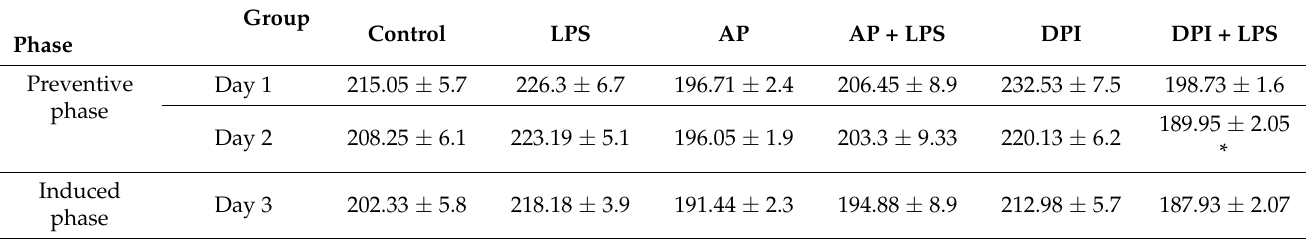
Table 1. Regular assessment of rat body weight (g) during pretreatment with apocynin, DPI and in- tranasal administration of LPS. Results are presented as mean ± S.E.M. ( n = 5 independent replicates). * p < 0.05, compared to the control